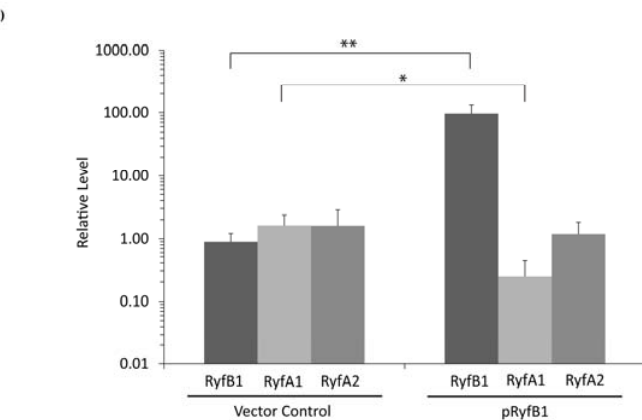
Figure 8. RyfB1 specifically inhibits RyfA1. ( a ) Next ‐ generation sequencing revealed ≈ 100 nt long transcripts immediately preceding, and divergent to, ryfA1 and ryfA2. The gene preceding ryfA1 has been termed ryfB1, while that preceding ryfA2 has been termed ryfB2 . ( b ) In silico analyses of RyfB1 revealed a region, in which 16 of 18 nucleotides share complementarity to sequences within RyfA1. Of note, this region of complementarity between RyfA1 and RyfB1 overlaps the five ‐ nucleotide variable region of the latter, indicated by the black box. Numbers indicate the base location relative to the 5 ′ end of each molecule (+1). ( c ) qRT ‐ PCR analyses of the relative levels of RyfB1, RyfA1, and RyfA2 in S. dysenteriae carrying the RyfB1 ‐ producing plasmid pRyfB1 or the vector control following growth of both strains under inducing conditions. The relative abundance of each target was calculated using the ΔΔ Ct method [24], in which target transcript levels are normalized to the level of rrsA present in each sample and are expressed relative to the level in that target in a single vector control sample. Data are the average of biological triplicates and errors bars indicate one standard deviation. * denotes a significant difference with p < 0.01 while ** denotes a significant difference with p < 0.001.